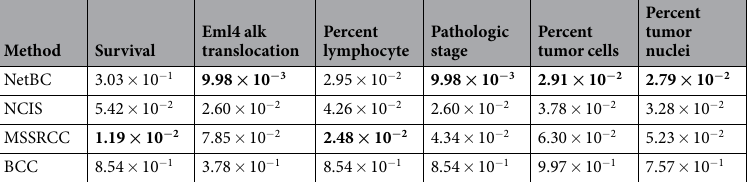
Table 1. p value of the dependence test between different clinical features and the discovered subtypes of Lung cancer. For the survival time, we use logrank test. For the eml4 alk translocation performed, percent lymphocyte infiltration, percent tumor nuclei, and percent tumor nuclei, we use the Chi-squared test. The p value is adjusted by Benjamini & Hochberg method. The smaller the p value, the better the performance is.